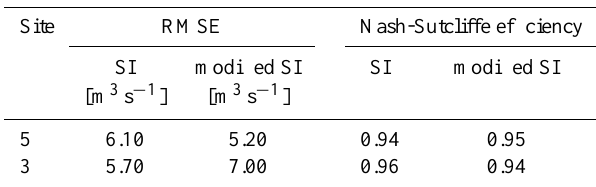
Table 7. RMSE and Nash-Sutcliffe efficiency calculated for the two stations with intermittent regime and for the standard and modified formulation of the stochastic index flow model. The Nash-Sutcliffe efficiency is calculated on logarithms of